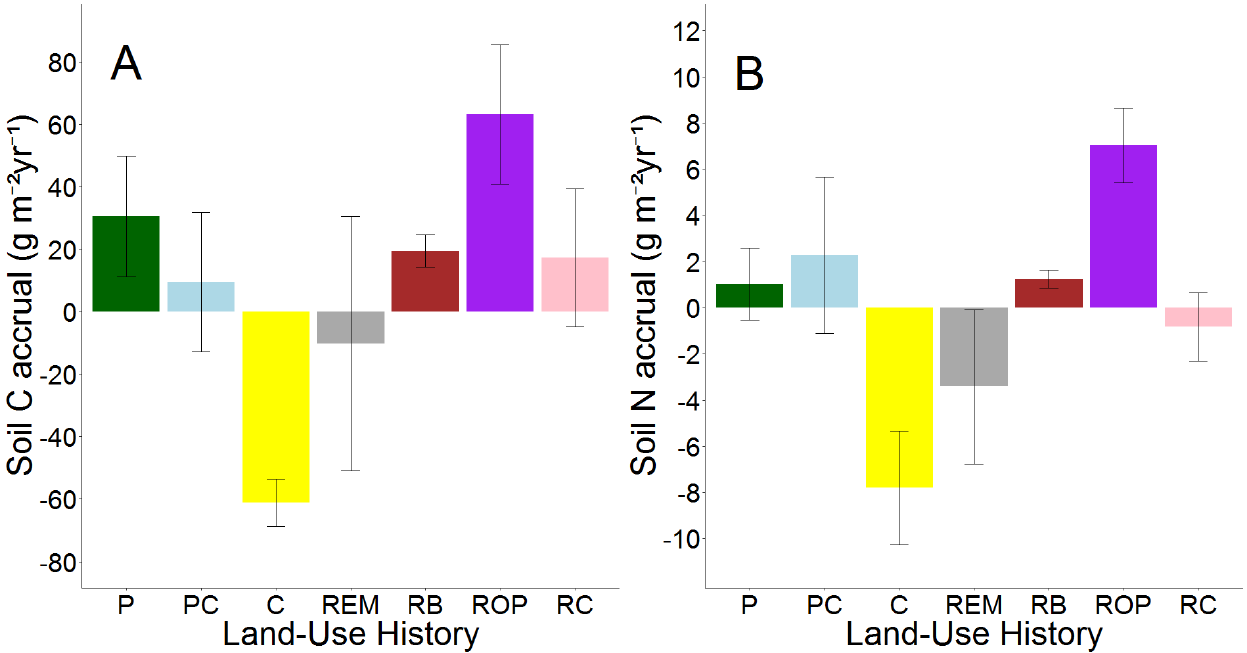
Figure 4. Means and S.E.M.s of soil C ( A ) and N ( B ) accrual from 2008 to 2018 by land-use history. Land-use histories are cow pasture (P), cow pasture converted from row crop (PC), row crop fields (C), remnant prairie (REM), bison prairie restored from P and PC pastures (RB), prairie restored from old pasture (ROP), and prairie restored from row crop (RC). Table 6. ANOVA estimates and 95% confidence intervals for relative change in 0–10 cm soil C and N concentrations (g C or N kg − 1 ) from 2008 to 2018 and 0–10 cm soil C and N accrual (g C or N m − 2 yr − 1 ) for land-use histories. Degrees of freedom are 6 (model) and 20 (residual). P is cow pasture, PC is pasture converted from row crop fields, C is row crop fields, REM is remnant prairie, RB is restored bison prairie, ROP is restored old pasture, and RC is restored from row crop fields. Response Variable Land-Use History Relative Change in g C kg − 1